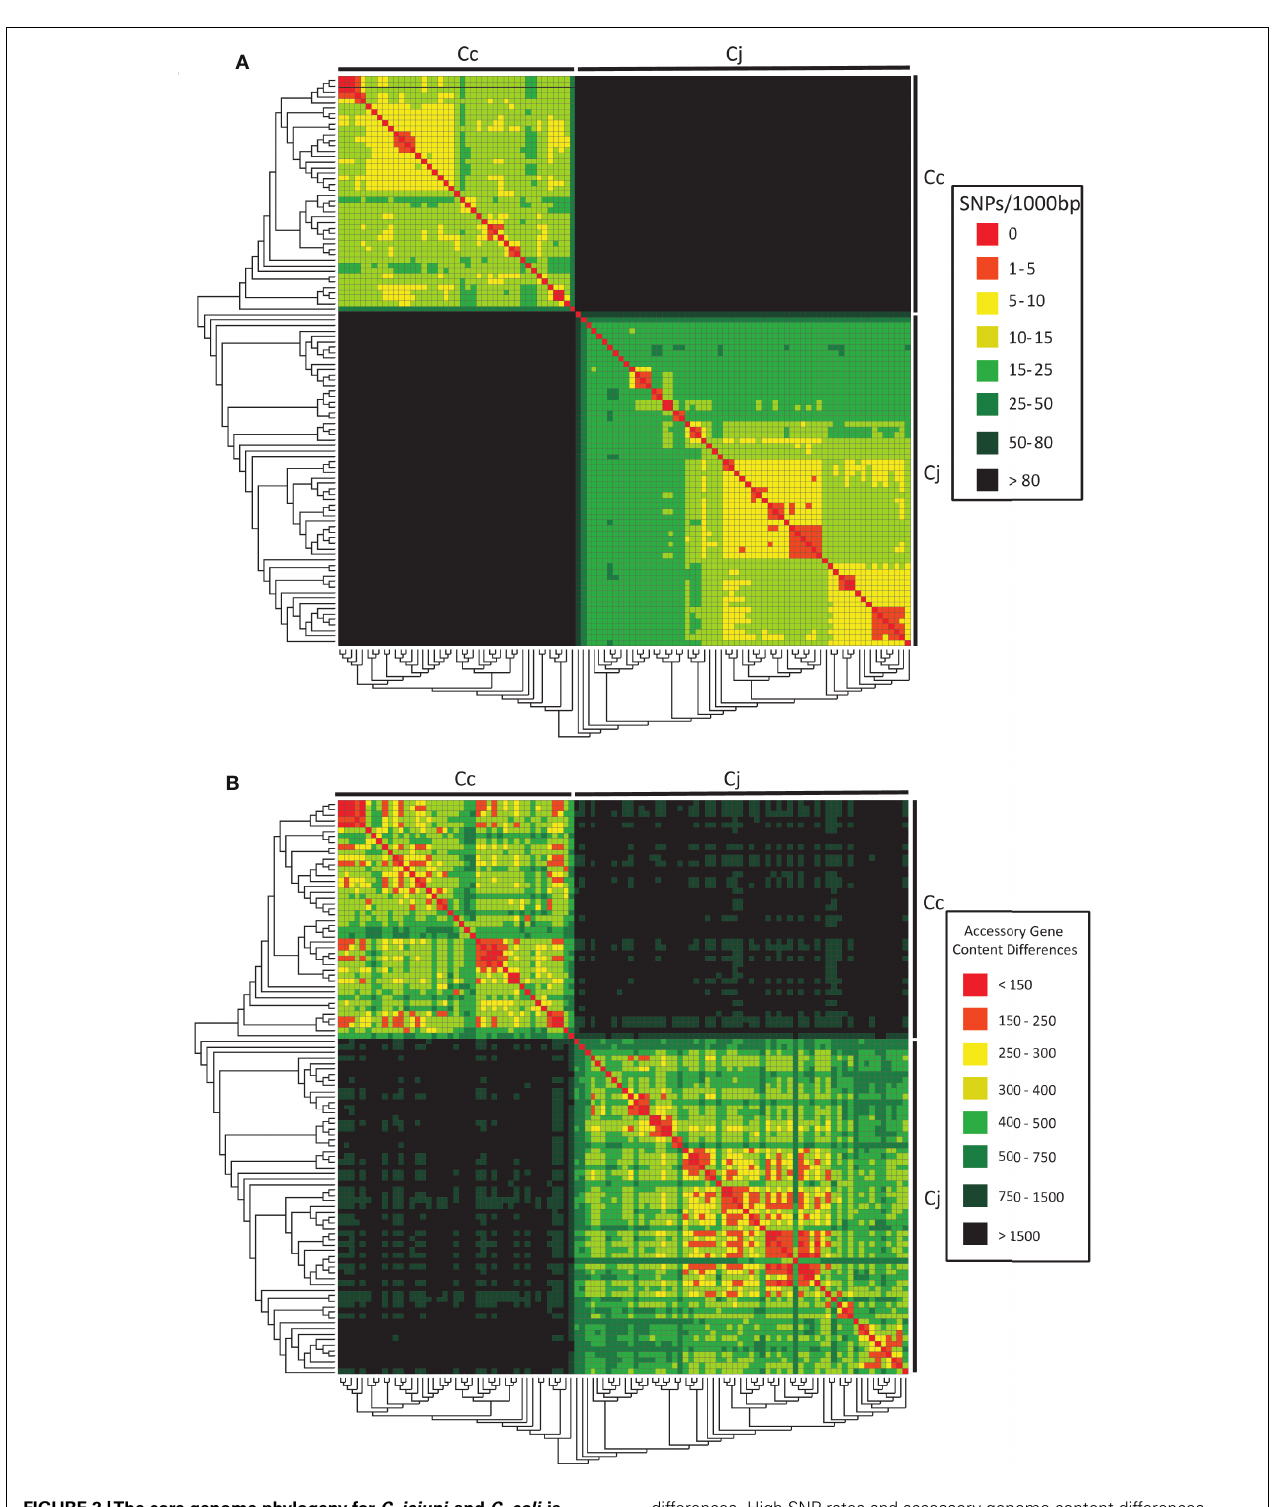
FIGURE 2 |The core genome phylogeny for C. jejuni and C. coli is consistent with underlying genome-wide SNP rates and accessory genome content. The 104 C. jejuni and C. coli WGS were analyzed using an automated pipeline for core genome analysis; a core gene phylogeny derived from 389 core genes is shown here.This phylogeny was compared to the underlying (A) SNP rates and (B) accessory gene content